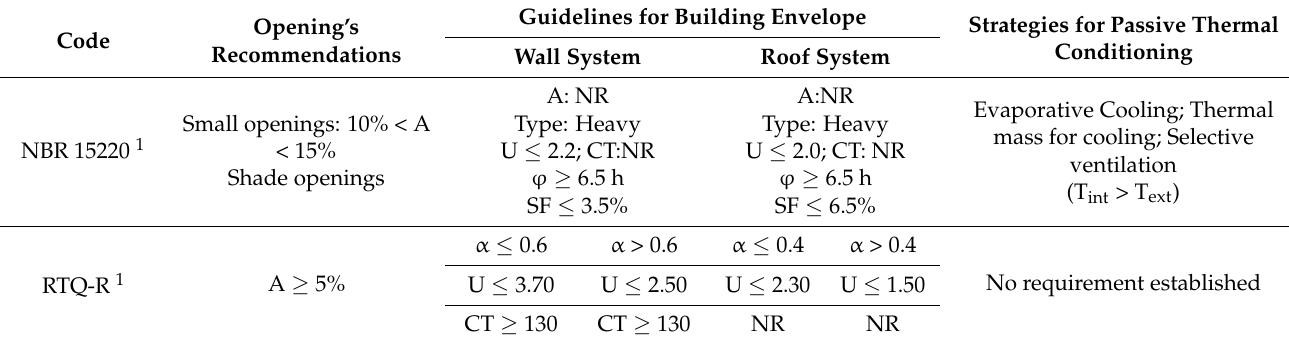
Table 1. Recommendations and constructive guidelines for the bioclimatic zoning of the building